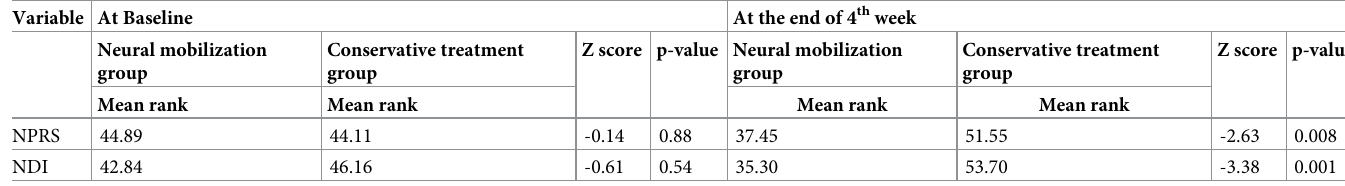
(Z = - 5.38, p = 0.00), mid-treatment and post-treatment (Z = -4.74, p < 0.001), and pretreat- ment and post-treatment (Z = -5.49, p < 0.001), showing that NPRS score was significantly improved after 2 weeks and further improved after 4 weeks of treatment in the control group. There was a statistically significant difference between pre, mid, and post-treatment NDI scores, Χ 2 = 72.11, p < 0.001. Post hoc analysis with Wilcoxon signed-rank was conducted with Bonferroni correction applied, resulting in a significant level set at p < 0.017. The Median (IQR) for pretreatment Neck Disability Score (NDI) in the control group was 40(30 to 49), mid-treatment was 30 (22 to 38) and post-treatment was 22 (16 to 30). There was a significant difference between pretreatment and mid-treatment (Z = -5.23, p < 0.001), mid-treatment and post-treatment (Z = -5.26, p < 0.001), and pretreatment and post-treatment (Z = -5.51, p < 0.001), showing that disability was significantly reduced after 2 weeks and further reduce after 4 weeks of treatment in the control group. Pre and post-treatment comparison of cervical ranges of motion score in group 2 has shown that post-treatment mean and standard deviation improved with p < 0.05, showing that conventional treatment is effective in improving cervical ranges in patients with cervical radiculopathy as shown in Table 4. A comparison of NDI between group 1 and group 2 has shown that there was no significant difference in NDI score at baseline and even after 2 weeks of treatment, as value p > .05, but there was a significant difference after 4 weeks in the neural mobilization group as the mean rank was 35.30 with p < 0.05 as shown in Table 5. Comparison of the mean and standard deviation of cervical range of motion between group 1 and group 2 has shown, that there was no significant difference in cervical ranges at baseline, after 2 nd and 4 th weeks of treatment, as p-value > .05, so experimental and control groups showed equal improvement as shown in Table 6. Table 5. Comparison of NPRS and NDI between the experimental and control group. Variable At